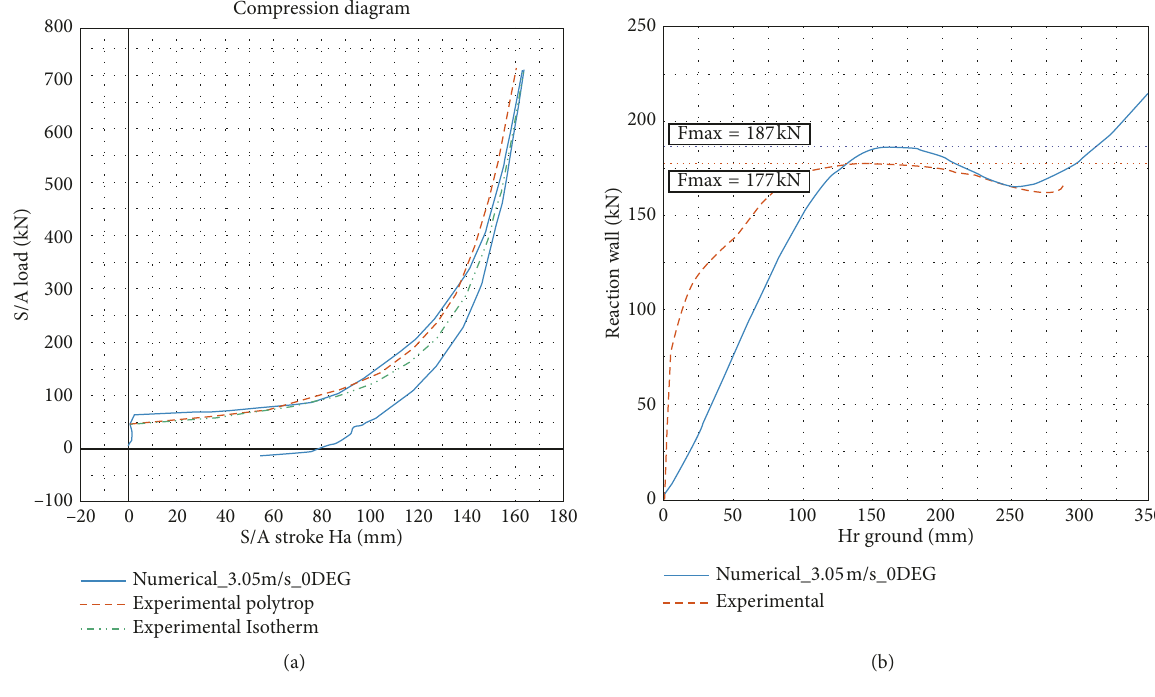
Figure 31: Shock absorber reaction vs. stroke